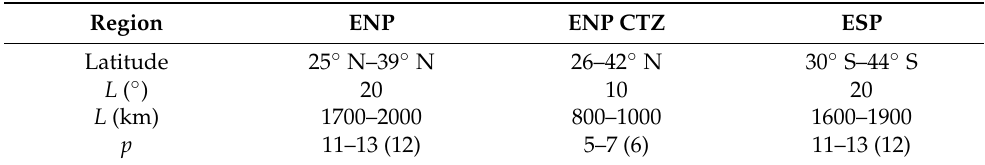
Table A1. Computed range for the number p of independent along-striation observations in the ENP (CTZ stands for coastal transition zone) and ESP using the minimum–maximum latitudes and estimated width L of the tilted boxes on Figures 2 and 3, and considering D = 150 km. The values finally retained for p are in